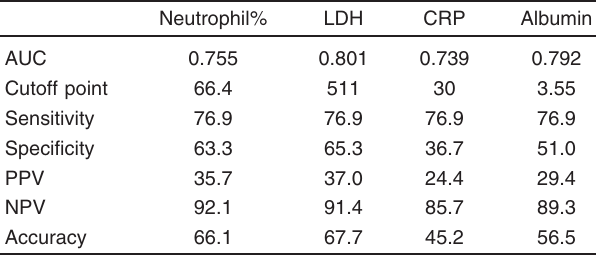
Table 5 Validity of neutrophil%, lactate dehydrogenase, C- reactive protein and serum albumin in predicting